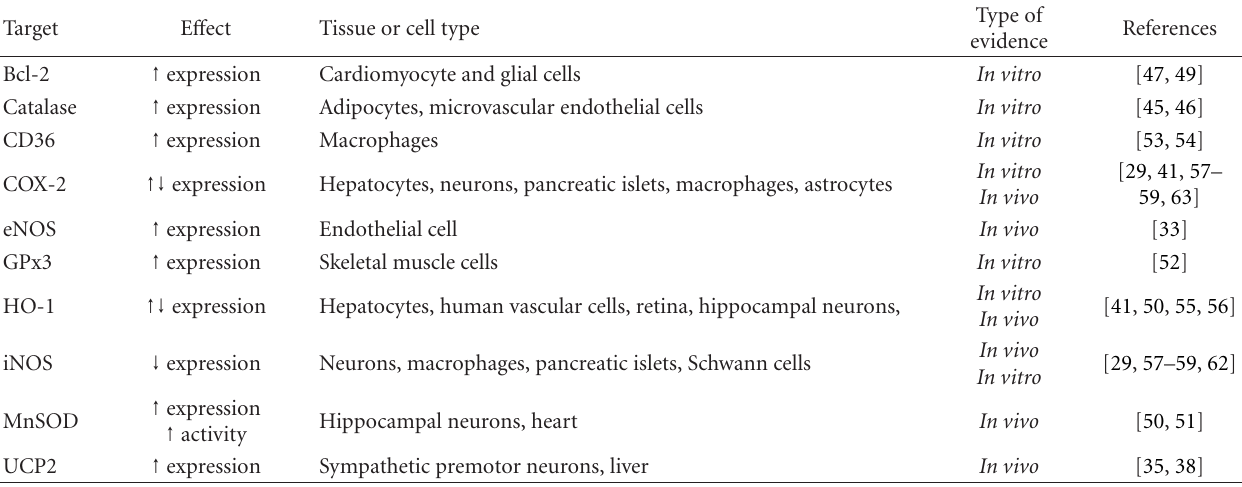
Table 1: Experimental data for PPAR γ -modulated genes during oxidative